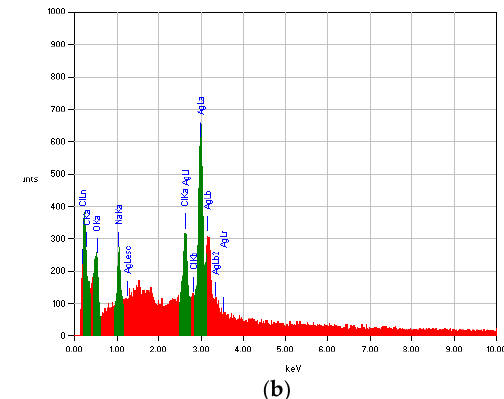
Figure 7. SEM image and EDX analysis of the silver-enriched beetroot–gelatin films: SEM image ( a ) and EDX spectra with indicated weighted contribution of chemical elements that were found in the produced films ( b ).